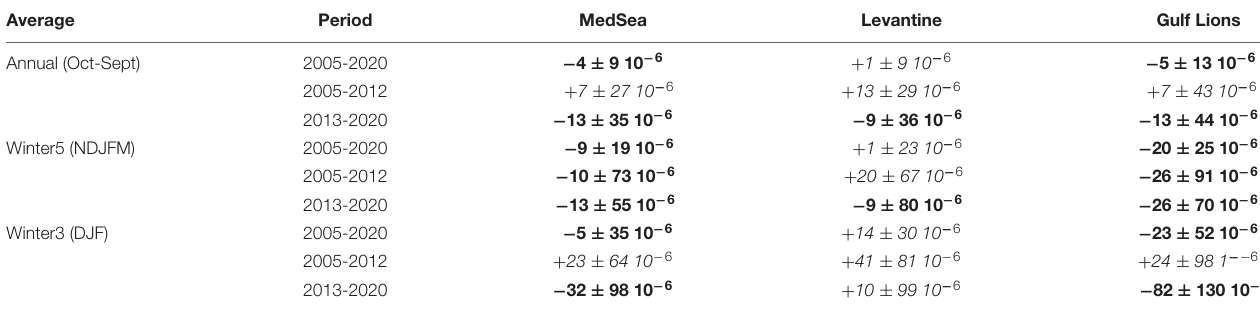
TABLE 2 | Estimated trends of averaged buoyancy flux (Nm − 2 s − 1 /decade) during the period of available data in the monitoring station with the 95% confidence interval. Average Period